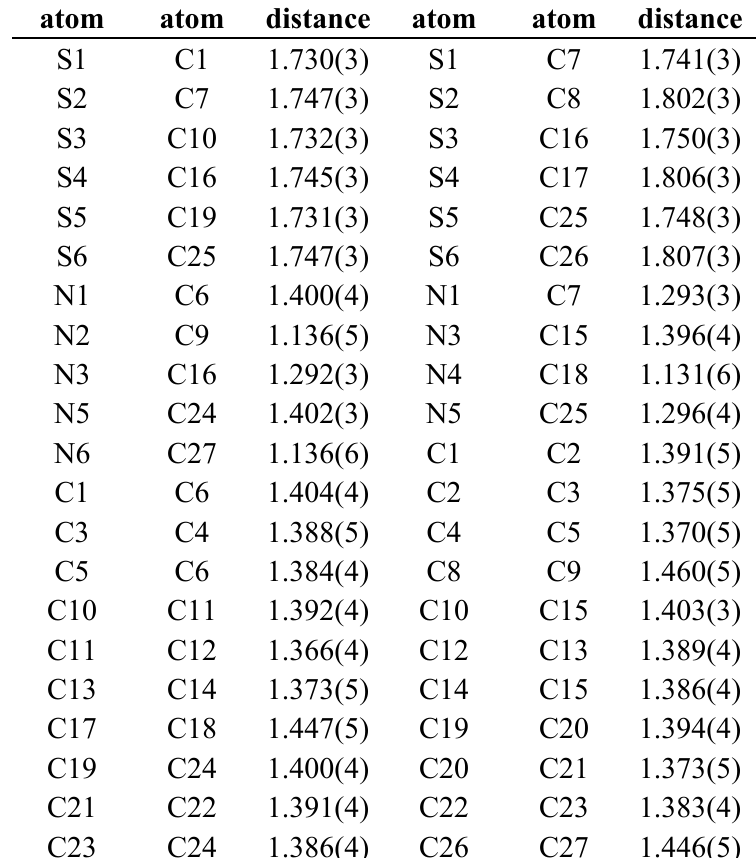
Table 1. Bond lengths (Å) for compound 2 .